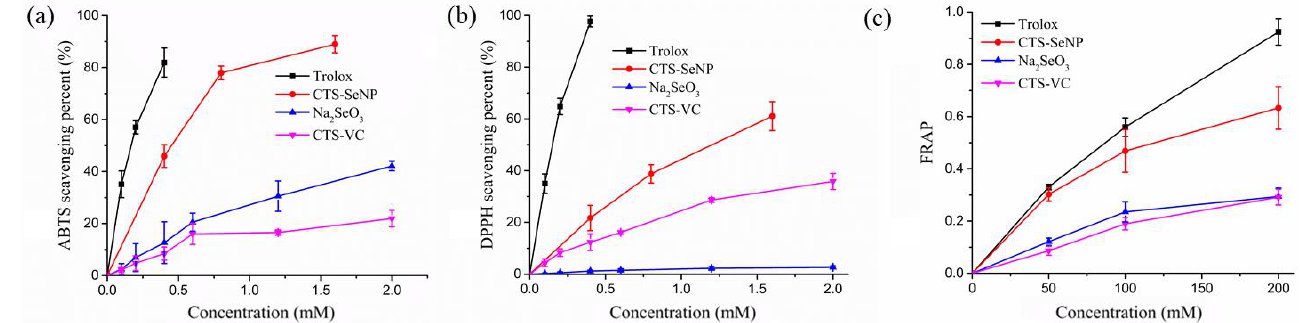
Figure 2. Antioxidant activity of SeNPs as determined by ( a ) ABTS, ( b ) DPPH and ( c ) FRAP assays. Trolox, Na 2 SeO 3 and Se-free solution were control groups. The results are expressed as means ± SD.